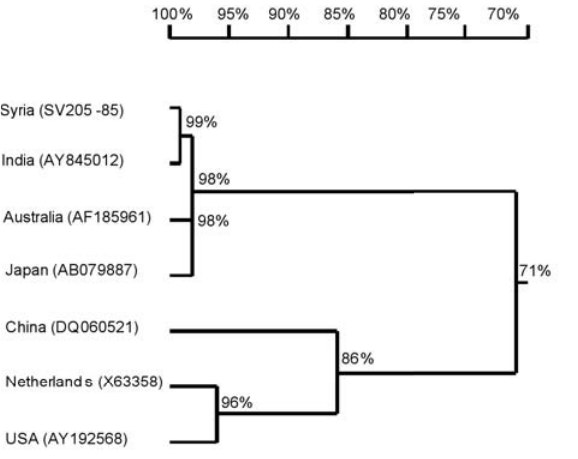
Fig. 2. Homology tree showing the relationship between different BYMV isolates including the Syrian isolate based on coat protein sequences. The tree was constructed using DNAMAN software with 1000 bootstrap replicates. Values at nodes indicate signi fi cance in bootstrap